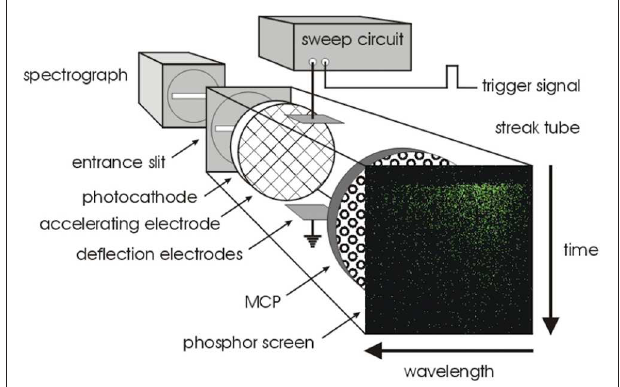
FIGURE 9 | Streak camera principle of operation. A photocathode converts photons into photoelectrons which pass through a pair of deflection plates, before being amplified and converted back into an optical image with a phosphor screen. Due to the deflection plates, timing information is converted into spatial information. Reproduced from Biskup et al.